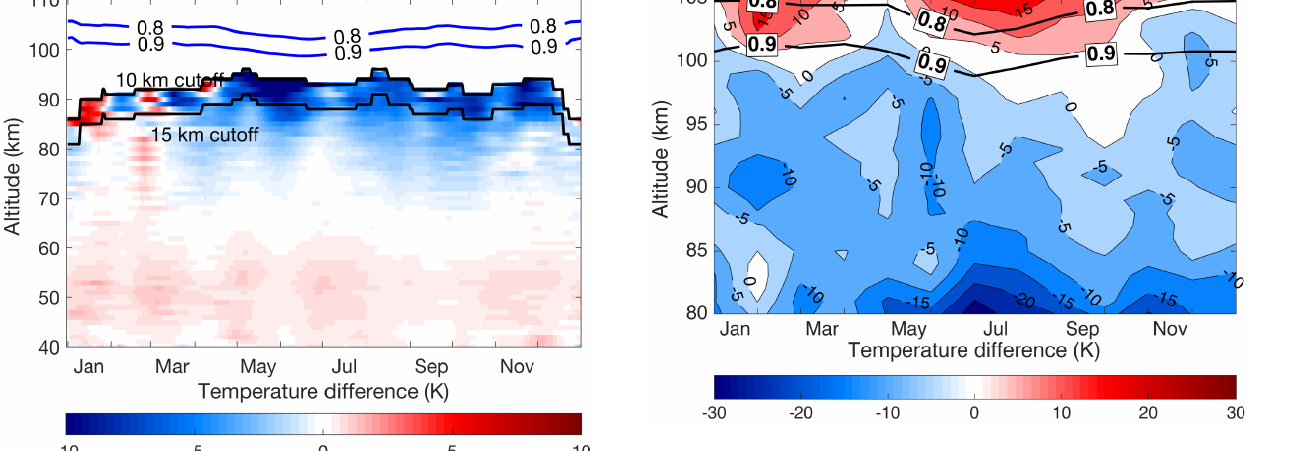
Figure 12. PCL temperature climatology difference from the URB sodium lidar climatology (PCL minus URB). The horizontal black lines are the height below which the temperature climatology is more than 90% (0.9) and 80% (0.8) due to the